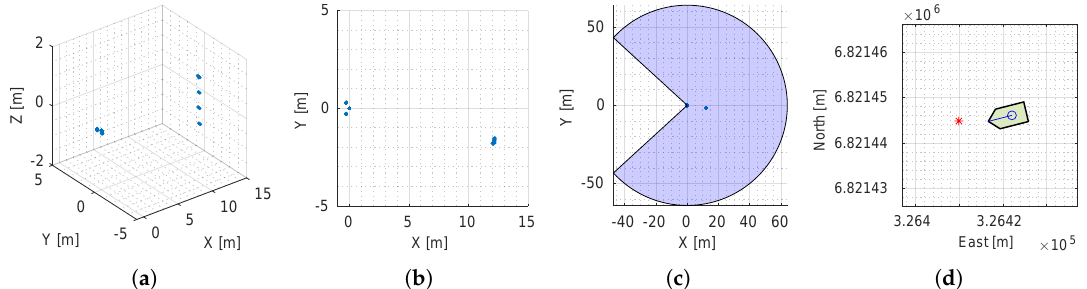
Figure 8. Post-processing of the LiDAR in the target detection algorithm: ( a ) LiDAR scan data in 3D. ( b ) LiDAR scan data in 2D. ( c ) Detection area of the USV in BODY including scan data. ( d ) Absolute position in NED of the